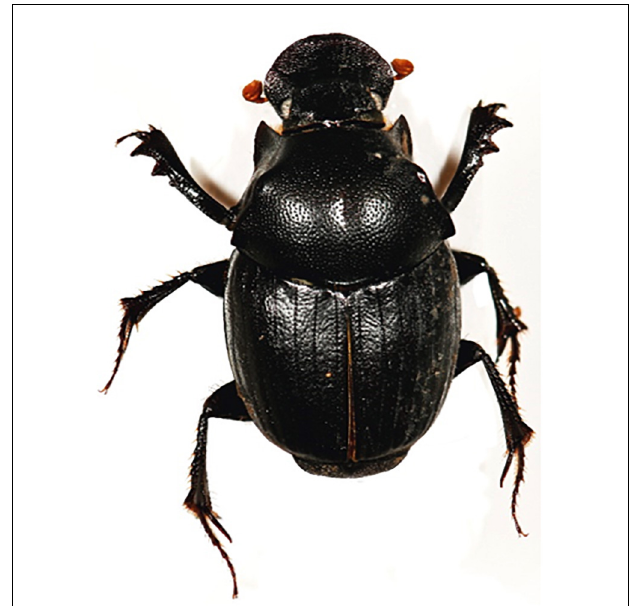
FIGURE 1 | A specimen Onthophagus lenzii